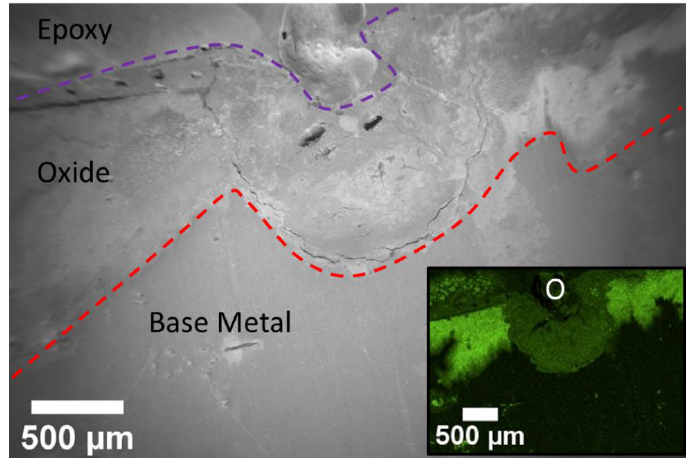
Figure 8. EDS map of a pit seen in the cross-section of the roughened sample. The inlay is the oxygen map. It shows the increase percentage of oxygen within the oxide layer. The pit has a lower concentration of oxygen due to brucite’s increase in porosity. The base metal has small pockets of oxygen indicating oxygen was diffusing through the metal.